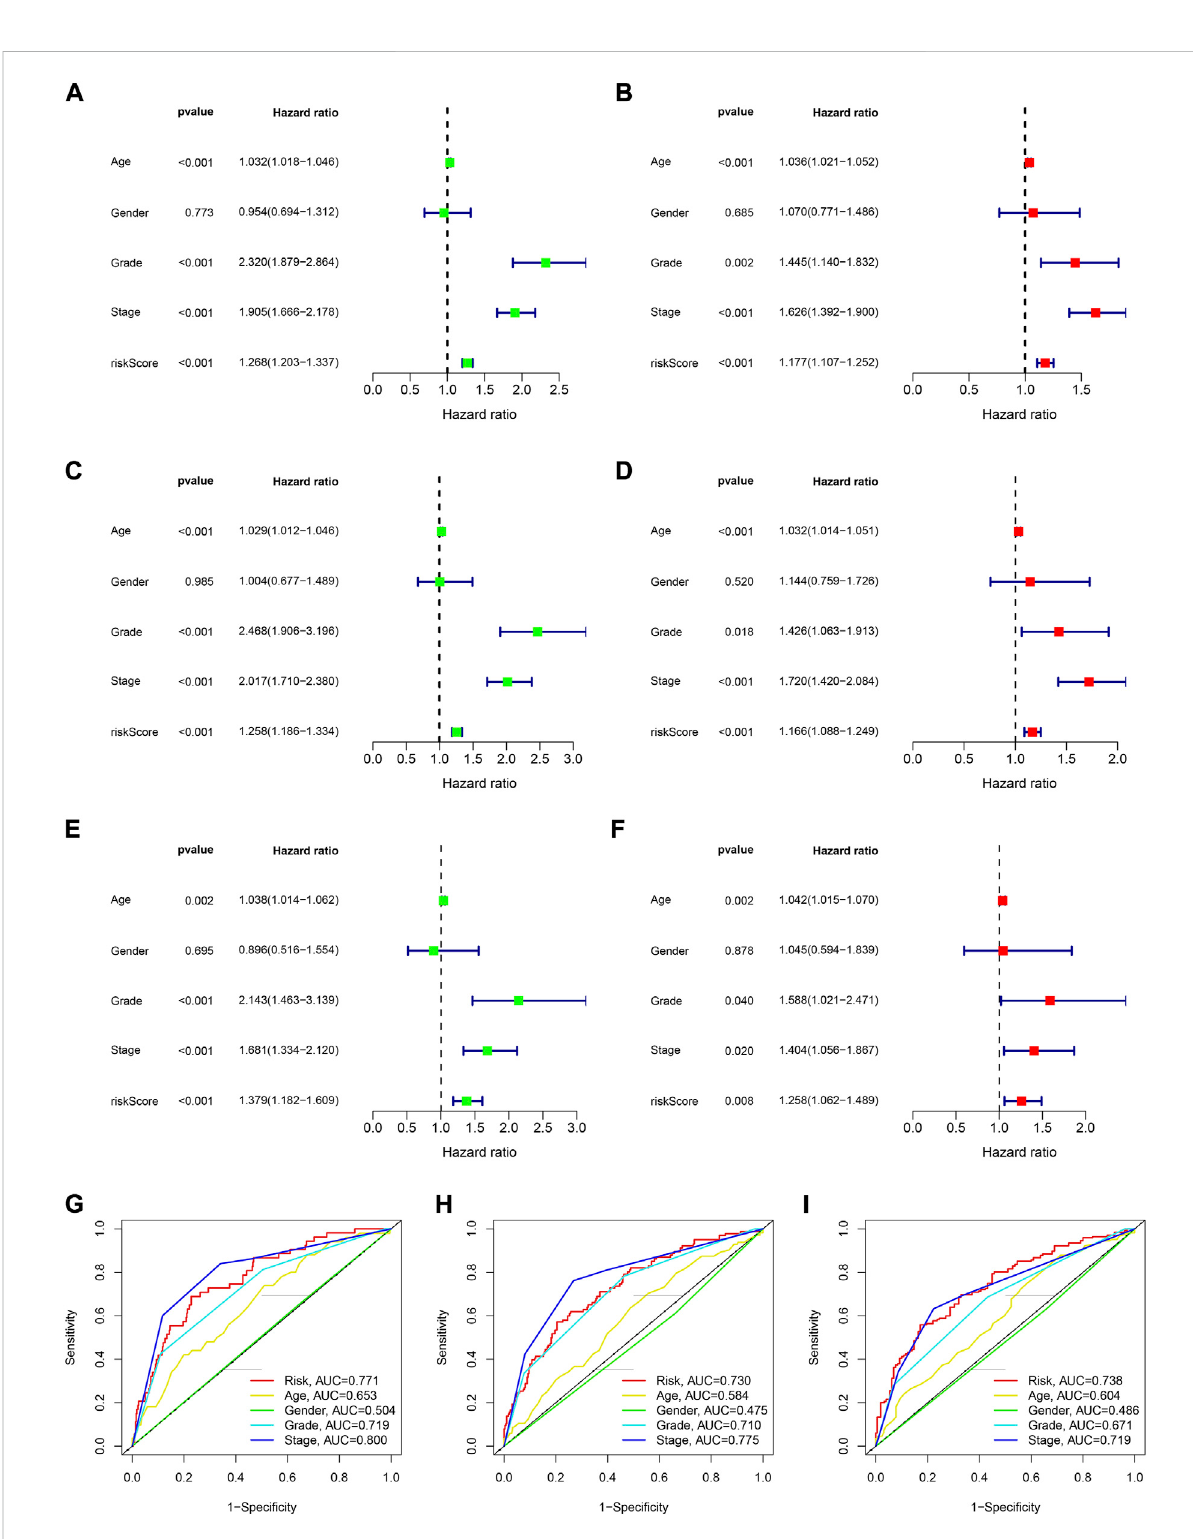
FIGURE 5 The assessment of independent prognostic factor. (A,B) Univariate and multivariate Cox regression analysis of the entire dataset (TCGA). (C,D) Univariate and multivariate Cox regression analysis of the training dataset. (E,F) Univariate and multivariate Cox regression analysis of the testing dataset. (G – I) 1-, 3- and 5-year ROC curves of riskScore and other clinicopathologic